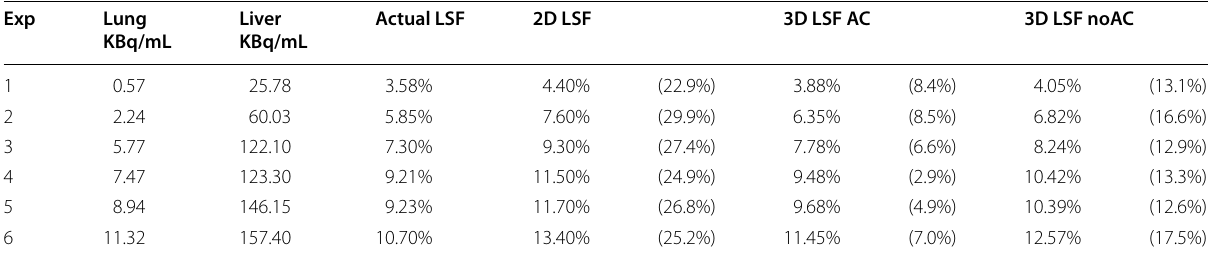
Table 2 Phantom experiments: LSF in planar imaging vs. SPECT/CT (with % SD from actual LSF in parenthesis)